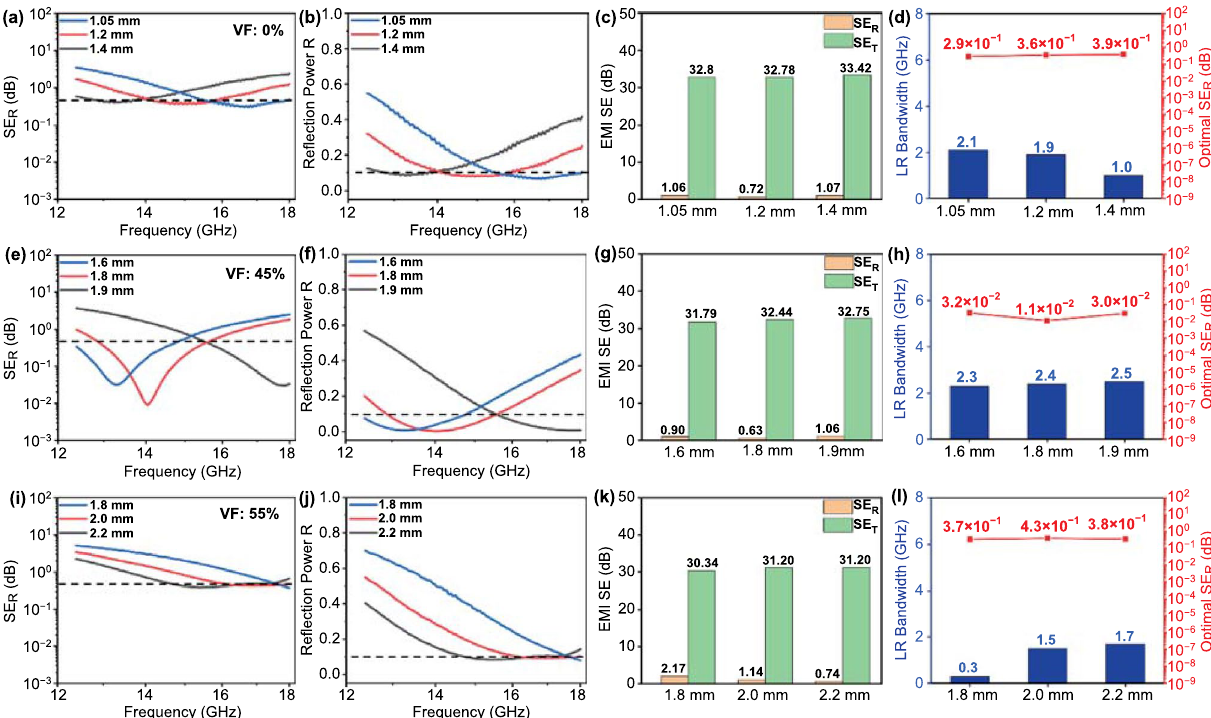
Fig. 5 EMI shielding performance for layered foam/film PVDF nanocomposites (30 wt% SiCnw) corresponding to different matching thick- nesses of absorption layer; a, e, i SE R ; b, f, j reflectivity R; c, g, k average value of SE R and SE T ; d, h, l low reflection bandwidth and minimal SE R value. Dependence of the VF: a‑d 0% VF; e–h 45% VF; and i‑l 55%